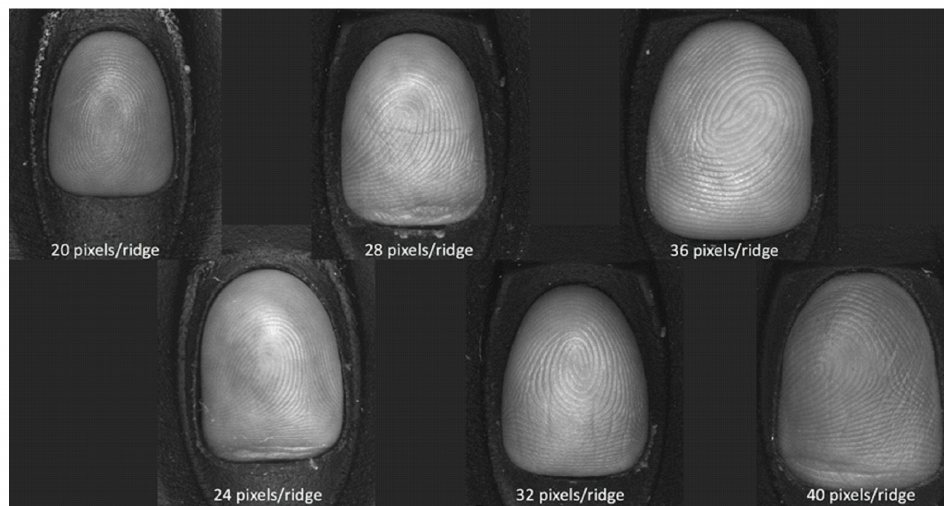
Figure 16. Variations in infant fingerprint ridge density.